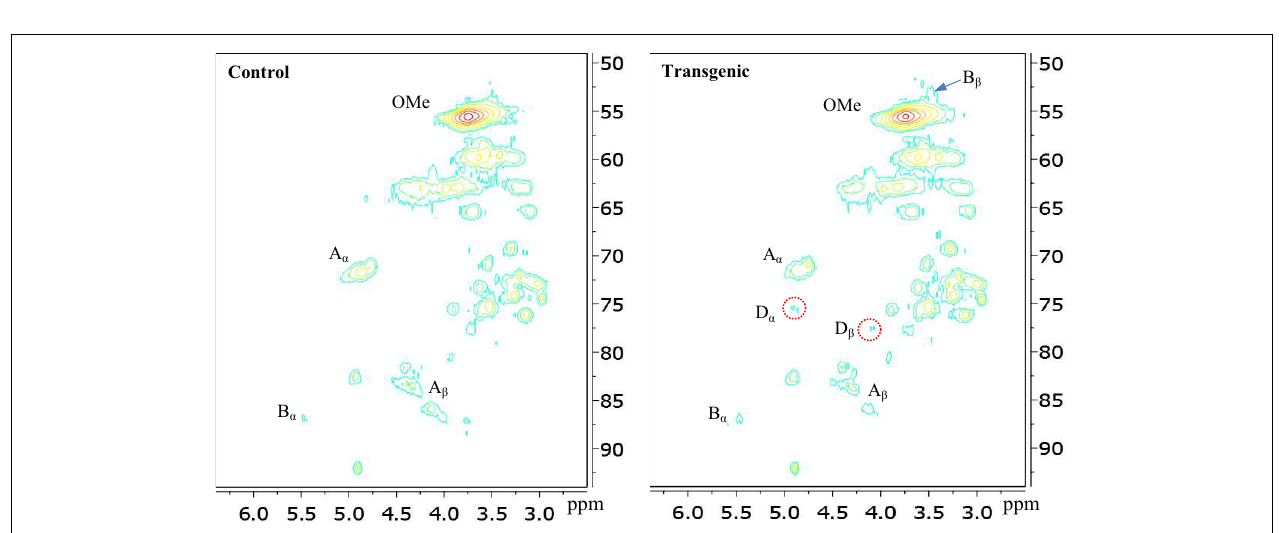
FIGURE 3 |Aromatic regions of 13 C- 1 H HSQC spectra of enzyme lignins isolated from control and transgenic internode I1 switchgrass . G, guaiacyl; S, syringyl; H, p -hydroxyphenyl; p CA, p -coumarate; FA, ferulate.